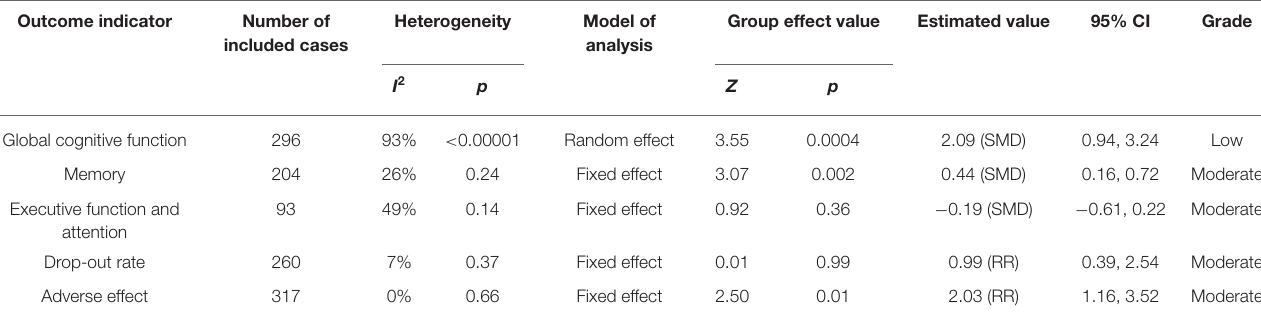
TABLE 2 | GRADE quality of evidence assessment of individual outcome indicators for the efficacy of repetitive transcranial magnetic stimulation in the treatment of mild cognitive impairment. Outcome indicator